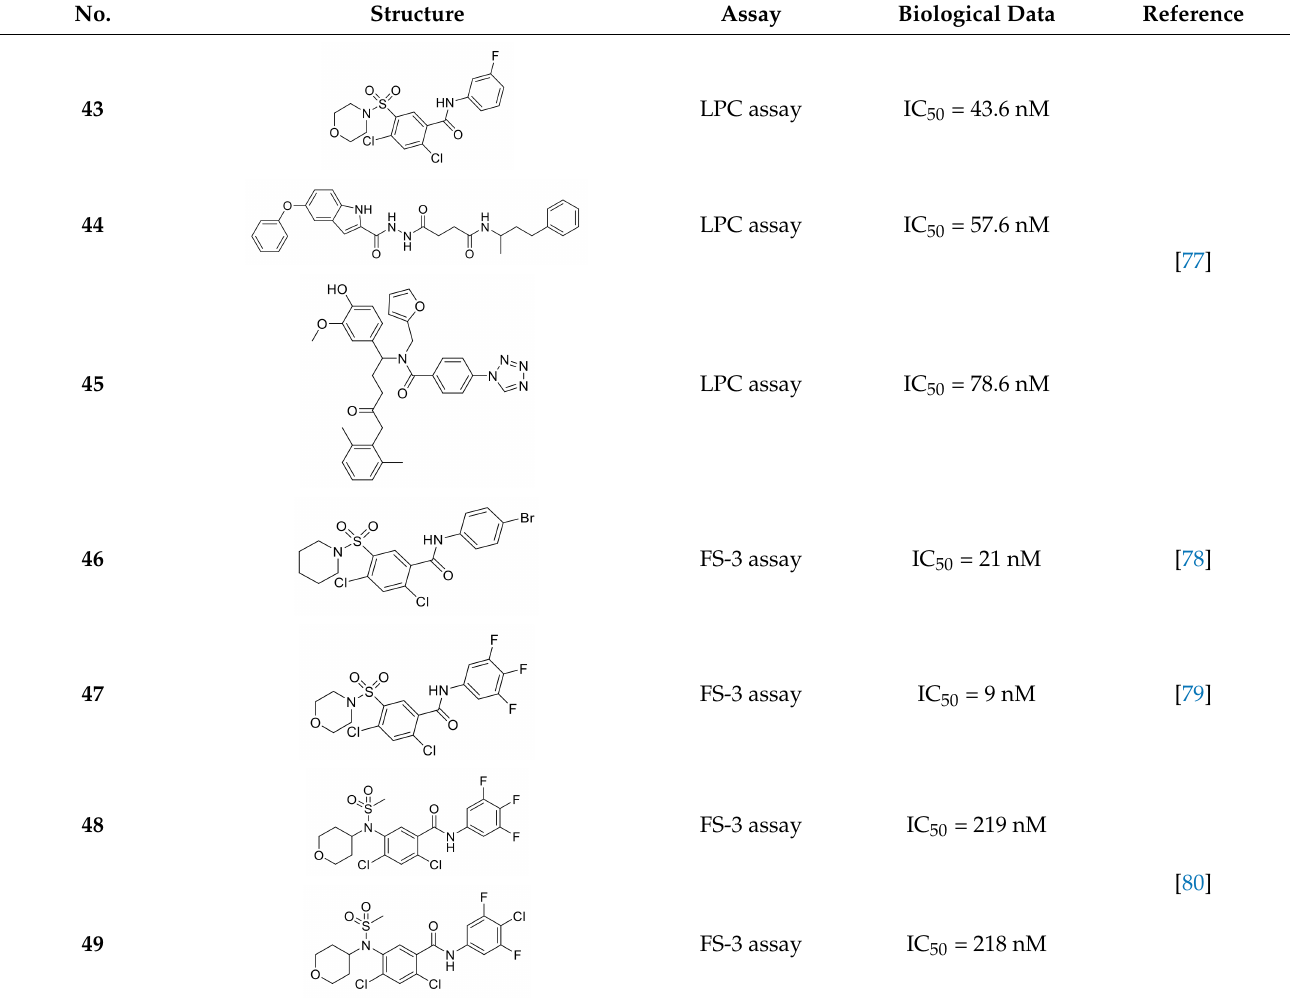
Table 4. Compound 43 – 62